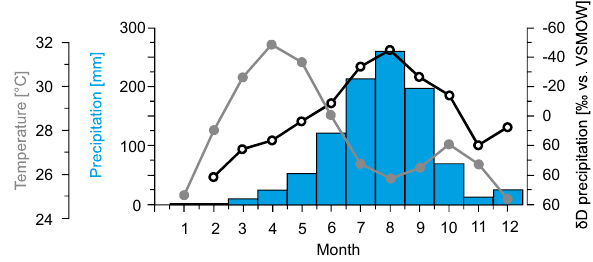
Figure 1. Monthly precipitation (blue), δ D of precipitation (black relative to Vienna Standard Mean Ocean Water) and temperature (grey) at Bamako (Mali; 12 ◦ 41 (cid:48) 24 (cid:48)(cid:48) N, 7 ◦ 59 (cid:48) 24 (cid:48)(cid:48) W; 381m) ex- emplifying the amount effect (Dansgaard, 1964) in West African hydrology (IAEA/WMO, 2014). This relationship is shown for monthly means, but also holds true on an annual basis (Rozanski et al.,